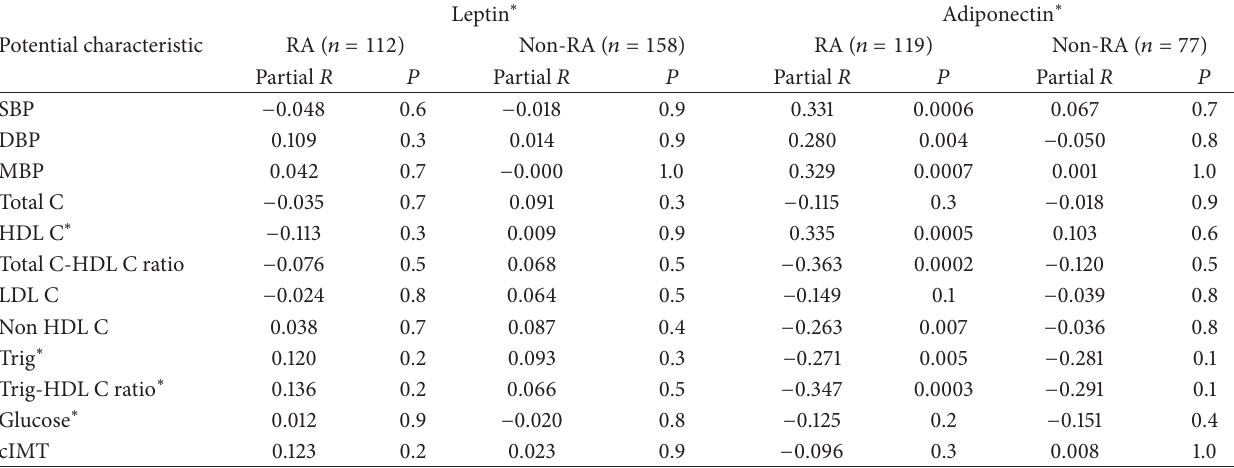
Table 4: Impact of RA on the independent relationships of serum leptin and adiponectin concentrations with metabolic risk factors and carotid